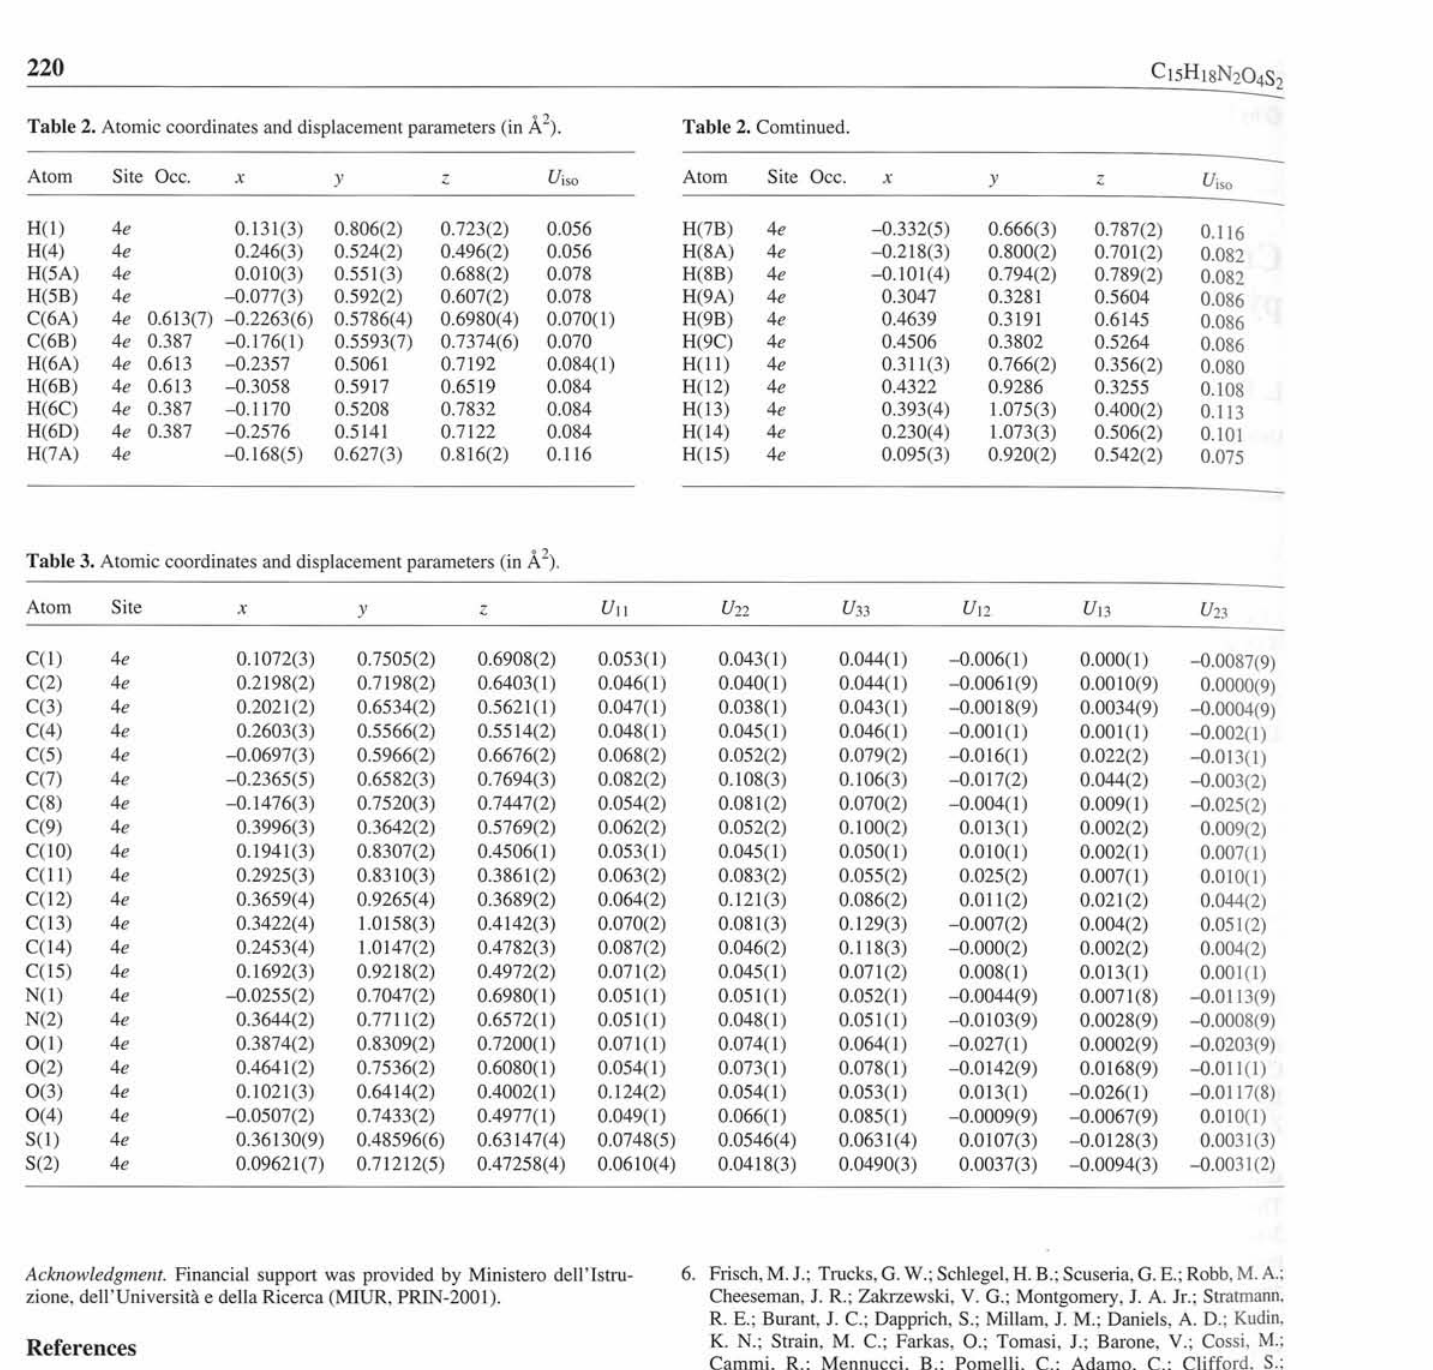
Table 2. Atomic coordinates and displacement parameters (in Â 2 ). Table 2. Comtinued.